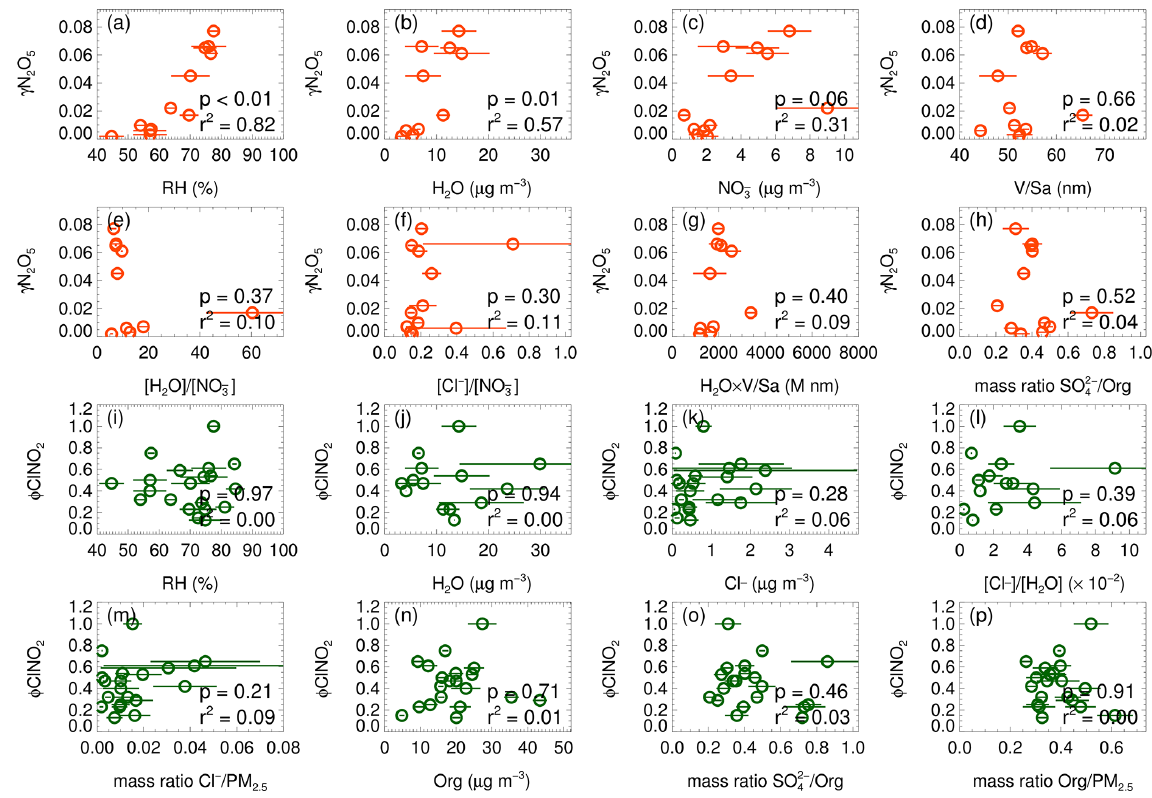
Figure 6. The estimated N 2 O 5 uptake coefficient and ClNO 2 yield versus related parameters.